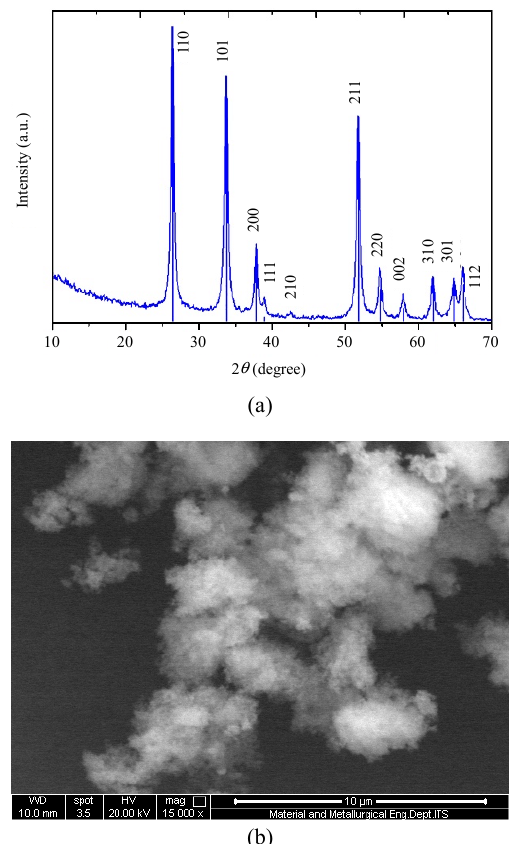
Fig. 2 Characterization of SnO 2 nanoparticles: (a) XRD pattern of SnO 2, indicating that the nanoparticles are tetragonal rutile shaped and (b) SEM images of SnO 2 nanoparticles.